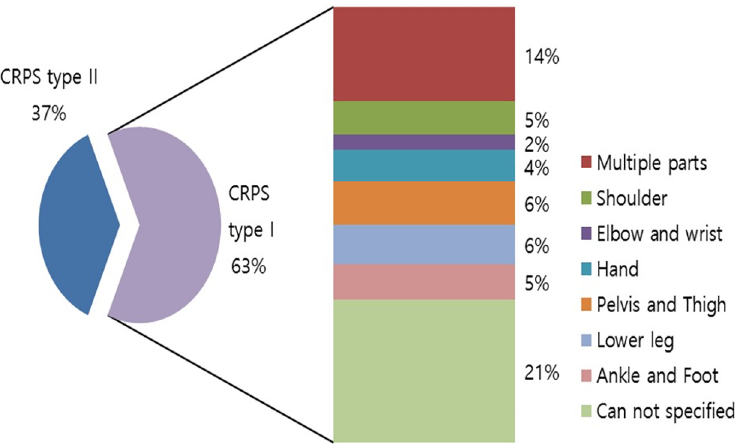
Fig 2. The involved body part in patients with CRPS in 2015.